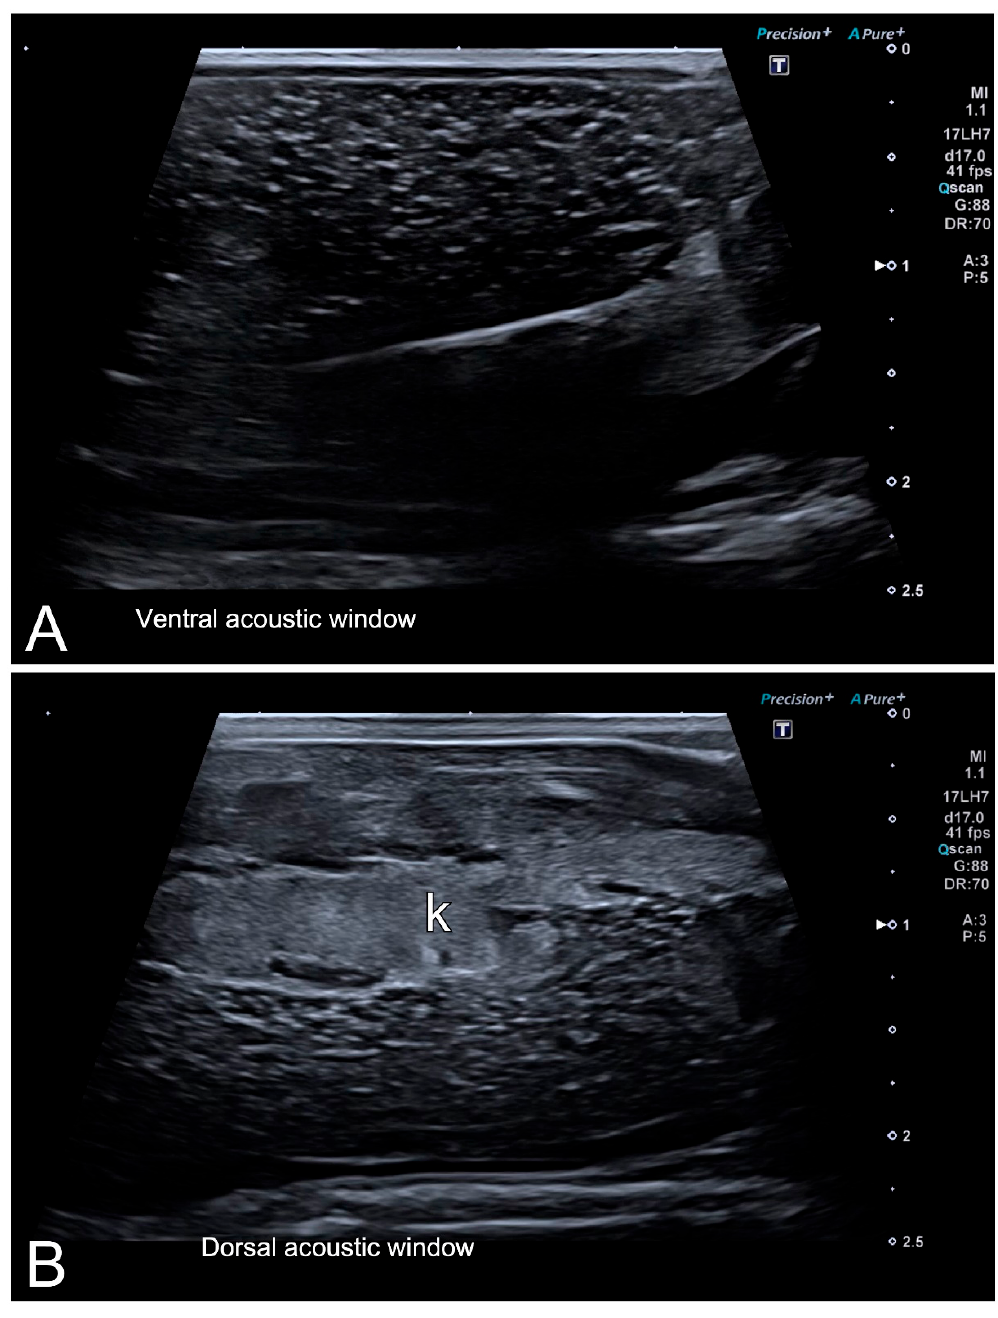
Figure 5. HR-US images of a female Xenopus laevis in the longitudinal plane using ventral ( A ) and dorsal ( B ) acoustic windows. Although the complex of follicles is clearly identified in both, the ventral acoustic window was considered more adequate for the examination of female gonads. Nevertheless, the kidney (k) was better identified using the dorsal acoustic window.